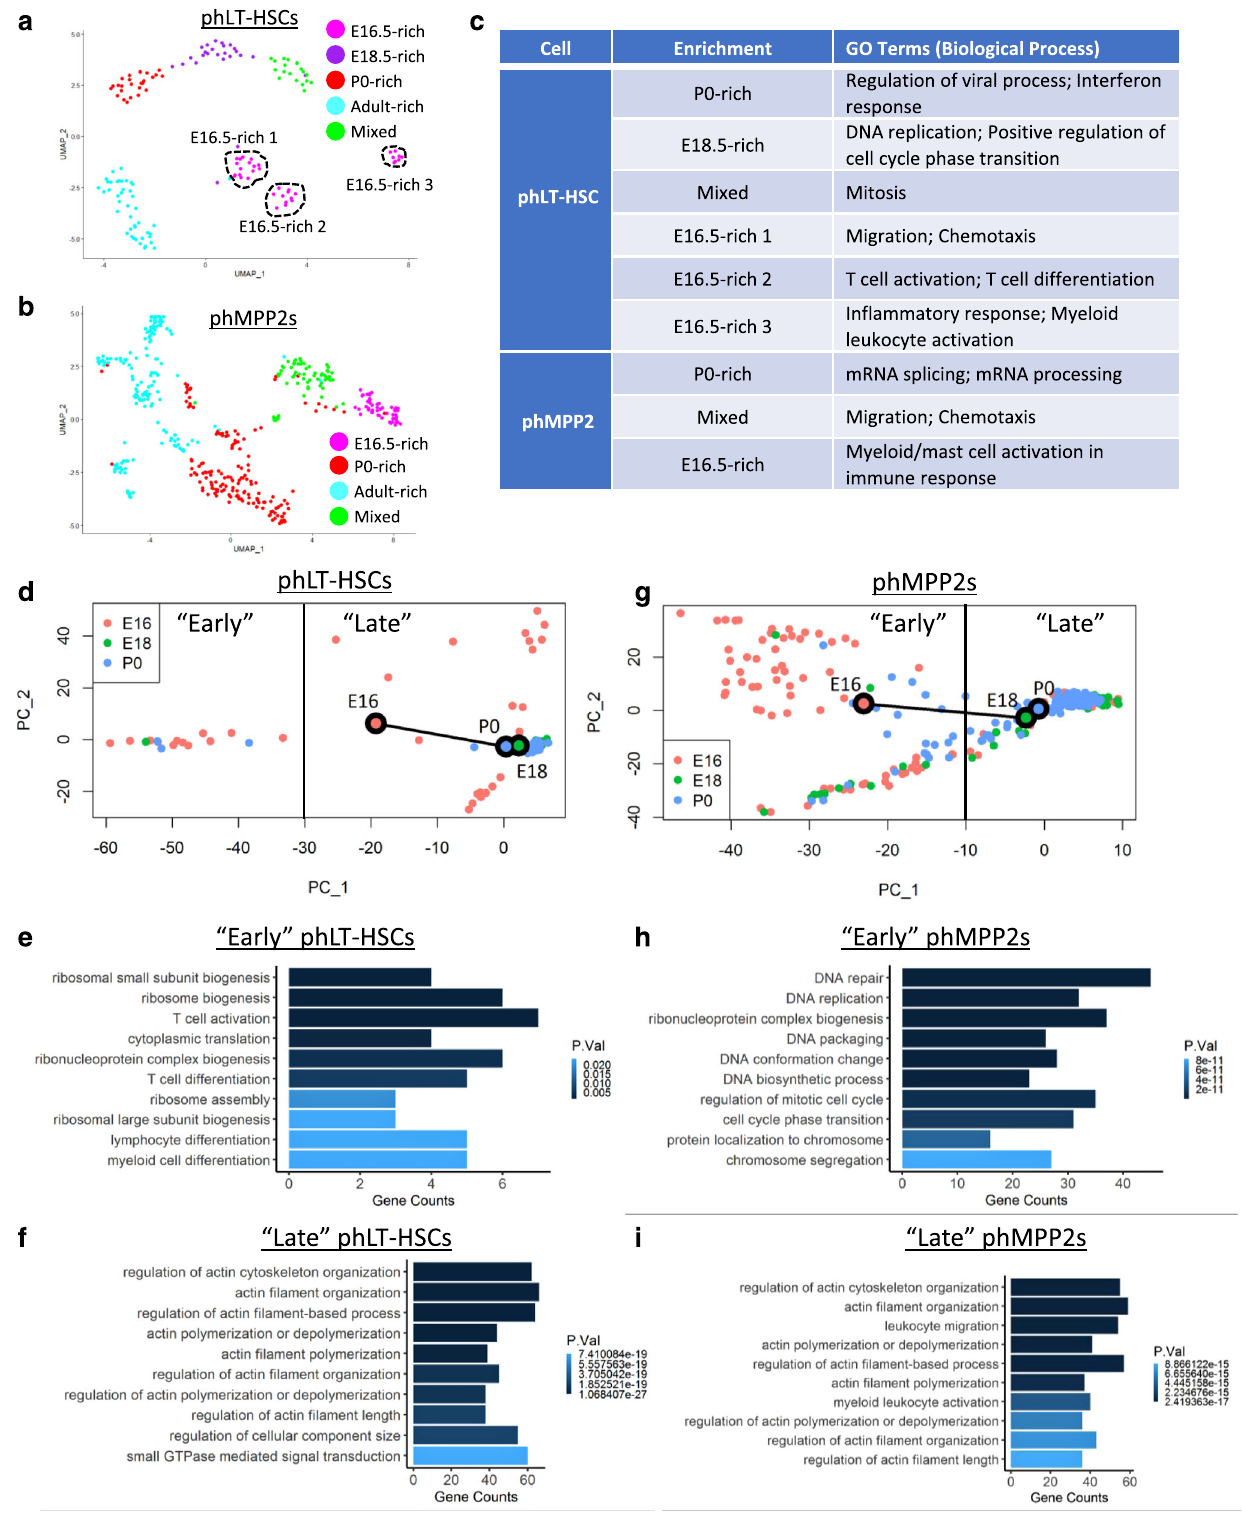
Fig. 5 | Early FBM HSPCs lack functional HSPC transcriptional programs. Inte- gration of phLT-HSCs ( a ) and phMPP2s ( b ) from all developmental timepoints. c Primary GO Terms for phLT-HSCs and phMPP2s. d Trajectory analysis and GO terms ( e , f ) of perinatal phLT-HSCs. g Trajectory anlaysis and GO terms ( h , i ) of perinatal phMPP2s. “ Early ” and “ Late ” cells were determined by dissecting PC1